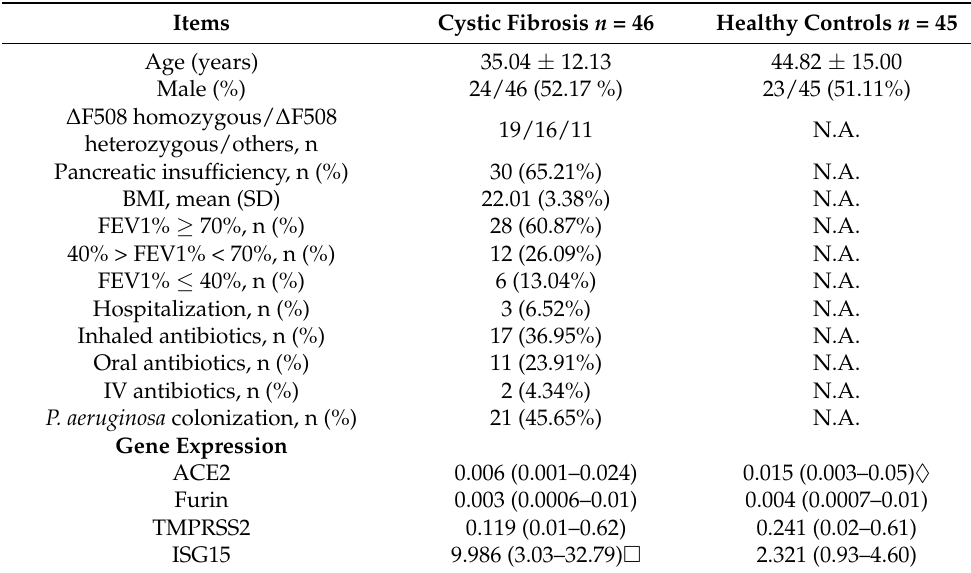
Table 1. Demographic, genetic, clinical features and expression levels of angiotensin-converting enzyme 2 (ACE2), furin, transmembrane serine protease 2 (TMPRSS2) and Interferon (IFN) stimulated gene 15 (ISG15) of cystic fibrosis (CF) patients ( n = 46) and healthy controls ( n = 45).